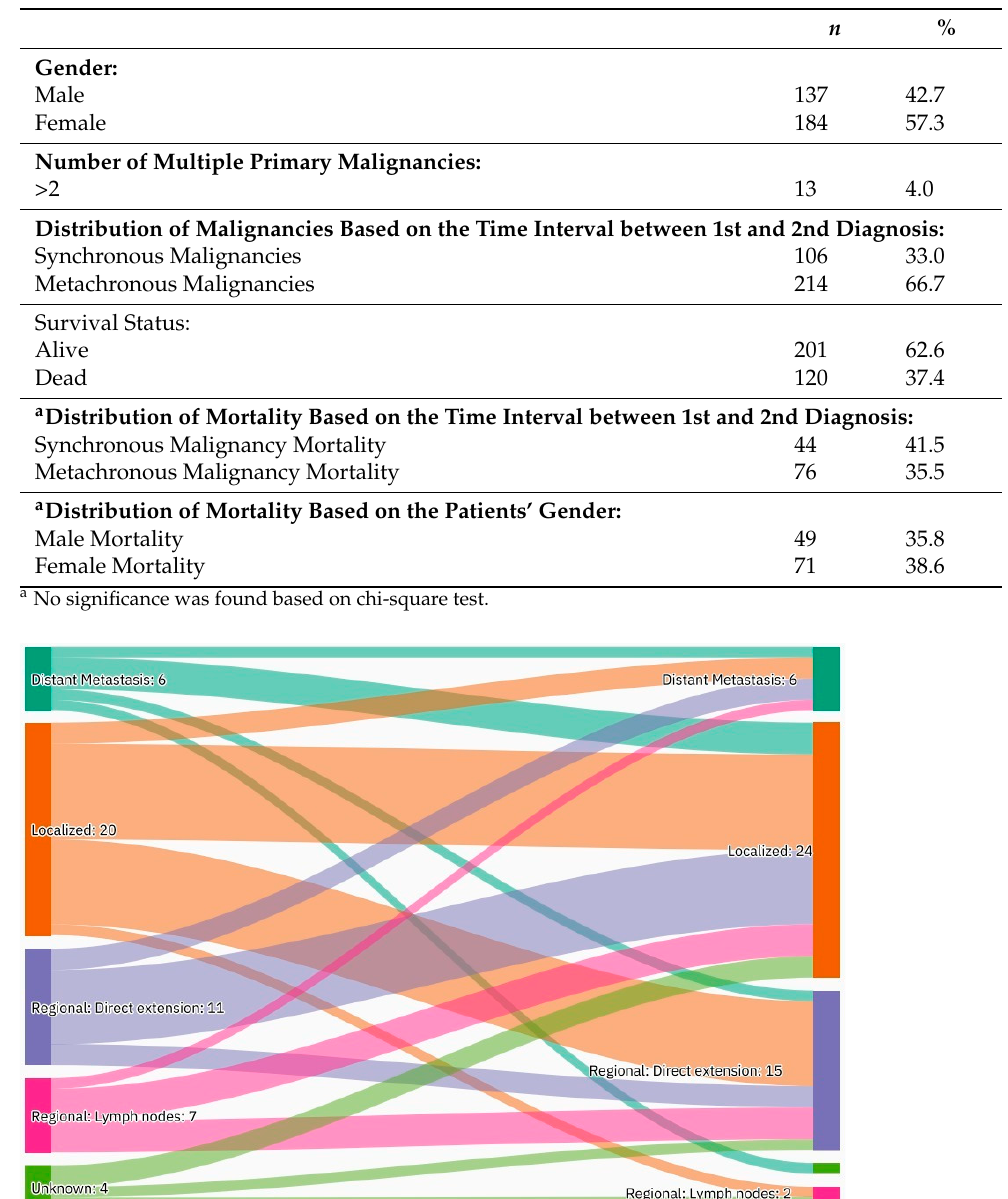
Table 1. General Information regarding Multiple Primary Malignancies.